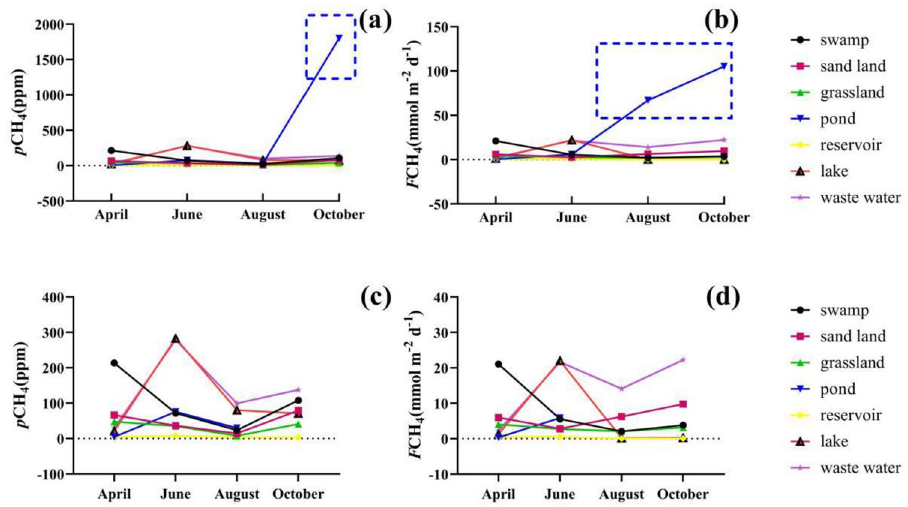
Figure 5. Temporal variation of p CH 4 ( a ) and F CH 4 ( b ) in the Xilin River in 2018 ( p CH 4 ( c ) and F CH 4 ( d ) except those points in the blue dotted box).